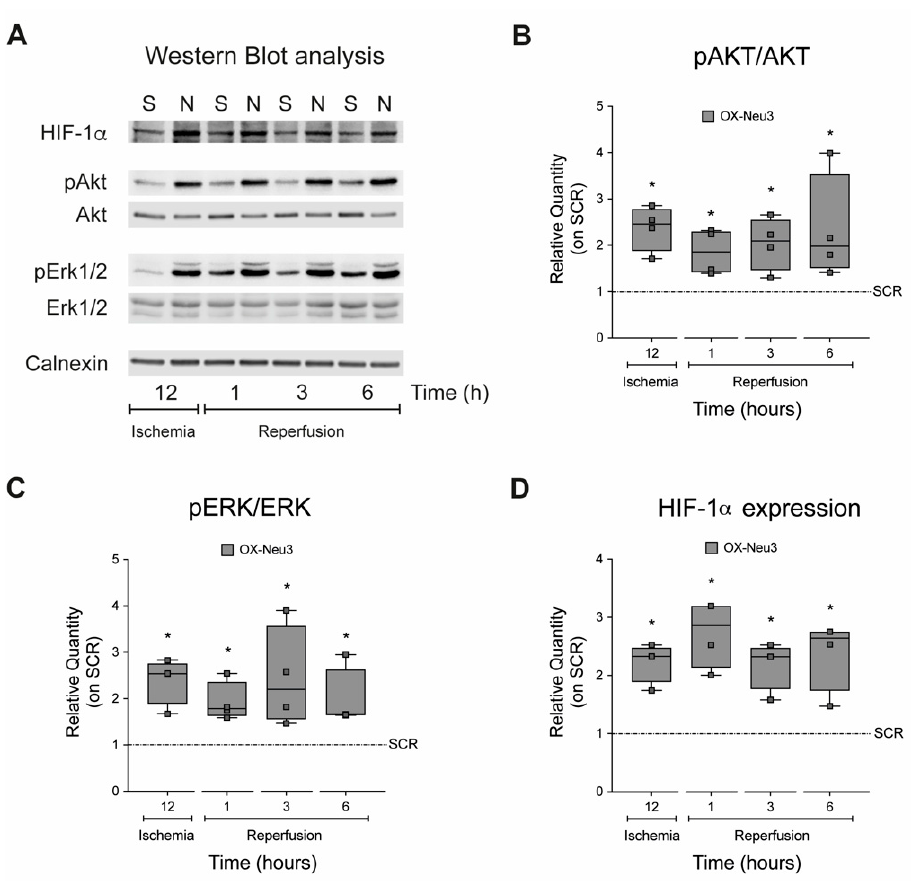
Figure 6. Effects of sialidase Neu3 overexpression on the RISK pathway activation and HIF- α expression. Activation of the RISK pathway and expression of HIF-1 α in scramble and OX-Neu3 cells exposed to IRI were evaluated by Western Blot. ( A ) Western Blot of HIF-1 α ; phospho-Akt (Thr308) and total Akt; phospho-Erk1/2 (Thr202/Tyr204) and total Erk1/2; Calnexin; ( B ) ratio between phospho-Akt (Thr308) and total Akt; ( C ) ratio between phosho-Erk1/2 (Thr202/Tyr204) and total Erk1/2; ( D ) HIF-1 α expression level. Calnexin was used as a housekeeper to normalize protein expression levels. “S” is the abbreviation for SCR cells; “N” is the abbreviation for OX-Neu3 cells. Data are expressed as relative amounts compared with scramble cells, used as internal control for each time point analyzed ( SCR dashed line ). Each square in the graphs represent an experimental